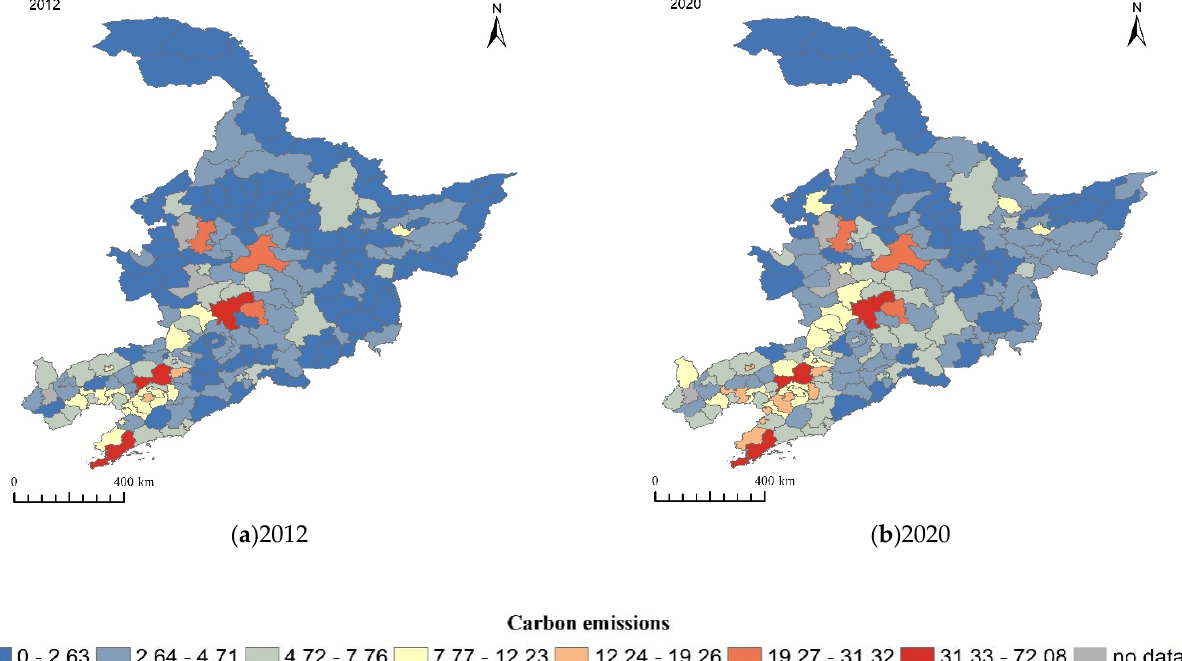
Figure 6. Spatial and temporal distribution of total carbon emissions in Northeast China in 2012 ( a ) and 2020 ( b